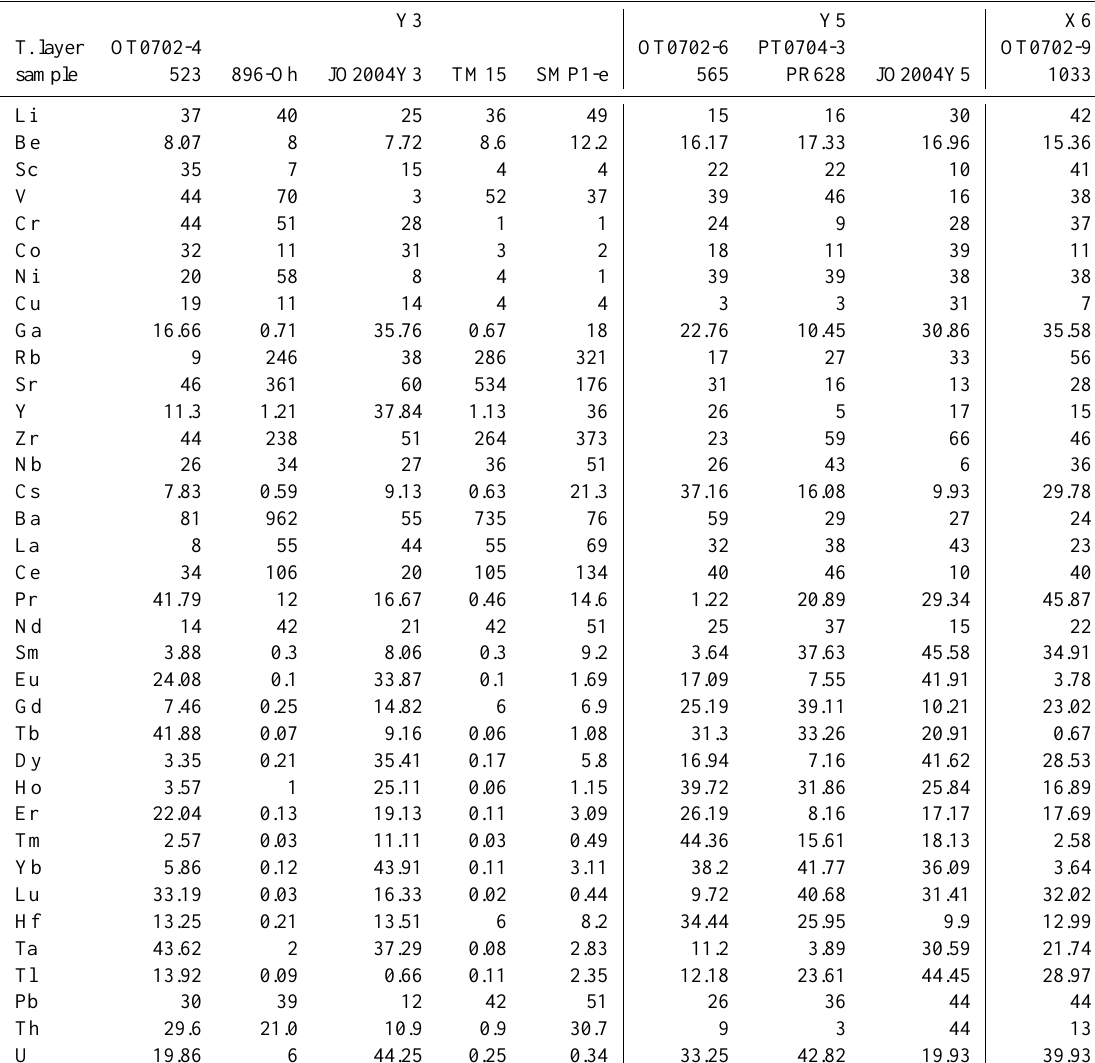
Table 3. ICP-MS trace element analyses of four selected samples from lakes Ohrid and Prespa: 523, 565, and 1033 are from core Co1202 (Lake Ohrid), PR628 from core Co1204 (Lake Prespa). Some analyses are reported for comparison and correlation: 896-Oh from core Lz1120 (Di Vito et al., 2008; Zanchetta et al., 2008); JO2004Y3 from core JO2004 (Albanian side of lake Ohrid; Caron et al., 2010; L´ezine et al., 2010); TM15 from Lago Grande di Monticchio succession (Wulf et al., 2004; sample courtesy of S. Wulf); SMP1-e from proximal deposits of SMP1-e/Y-3 deposits (Di Vito et al., 2008); JO2004Y5 from core JO2004 (Albanian side of lake Ohrid; Caron et al., 2010; L´ezine et al., 2010). Y3 T.